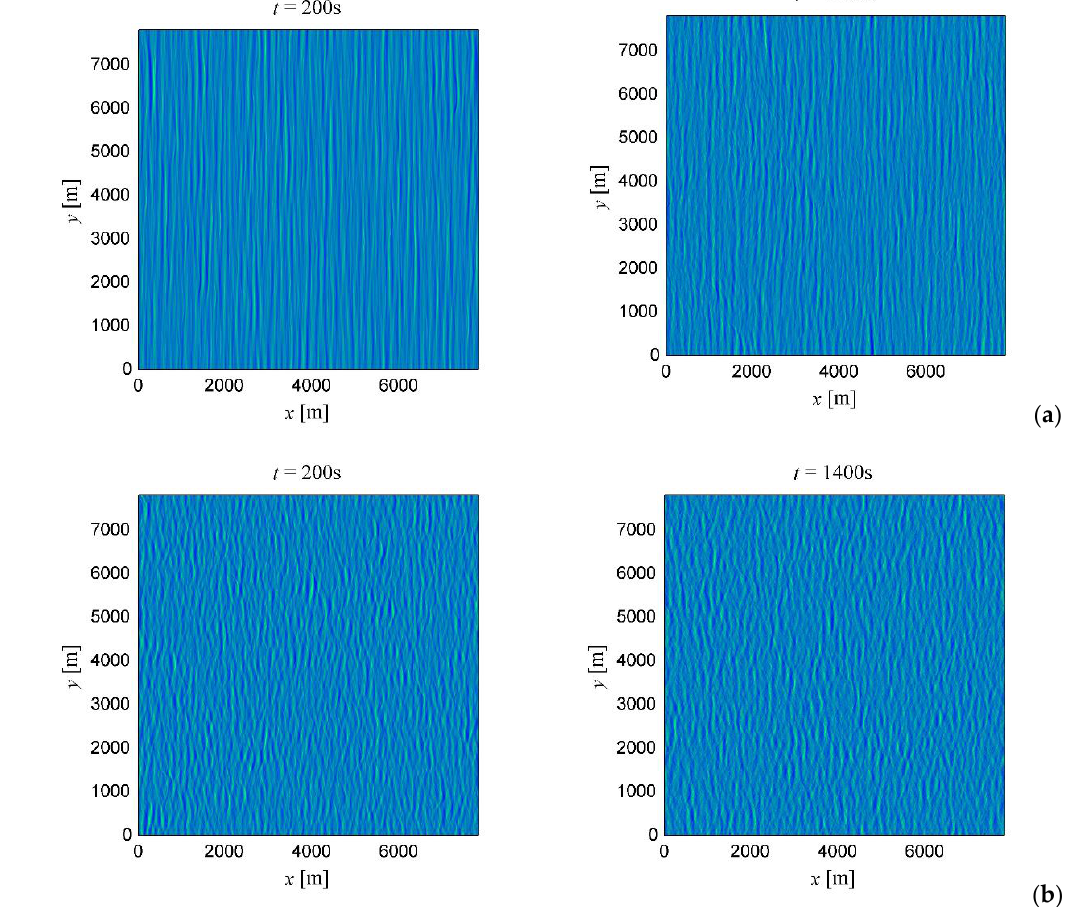
Figure 1. Examples of the simulated sea surfaces: ( a ) Series E 12 and ( b ) series E 62 .